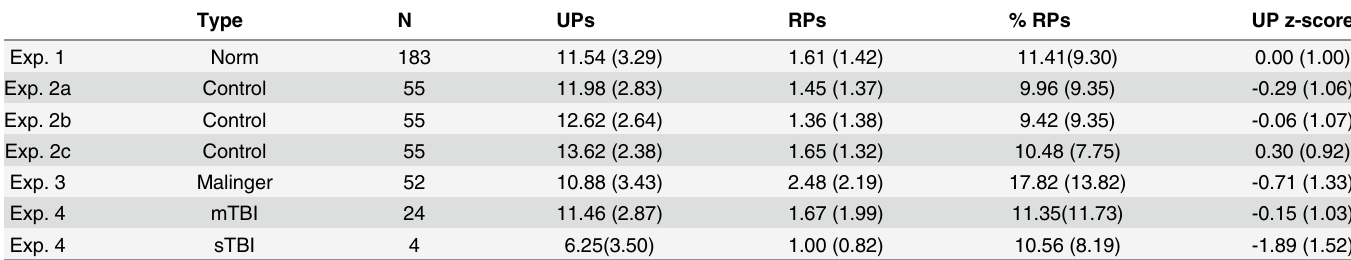
Table 3. Mean results from the four experiments.